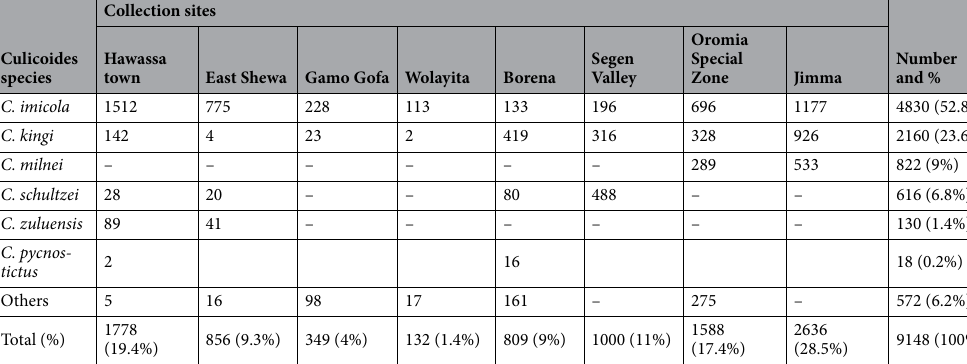
Table 2. Culicoides species collected across the study sites.